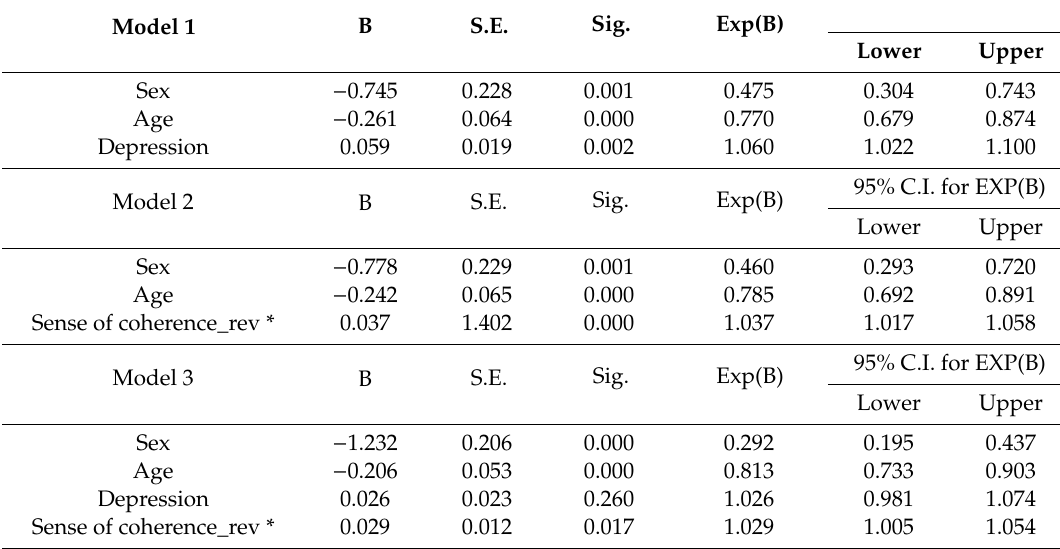
Table 4. The binary logistic regression analysis of depression and sense of coherence to energy drink addiction, controlled for sex and